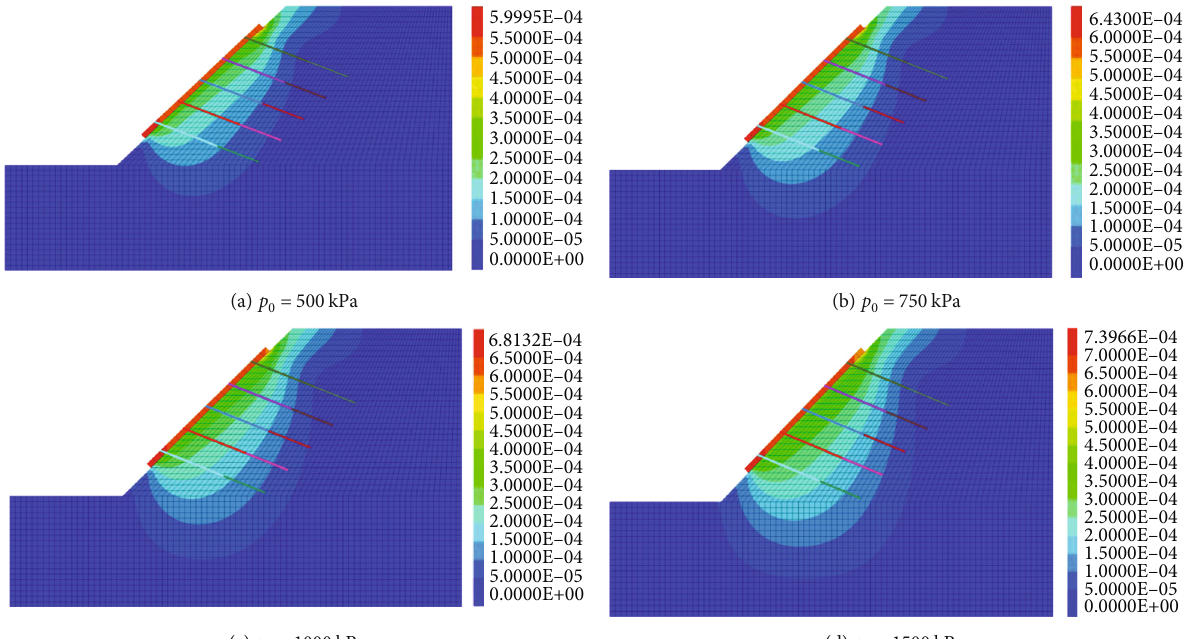
Figure 14: The displacement nephogram of the slope under di ff erent prestresses.